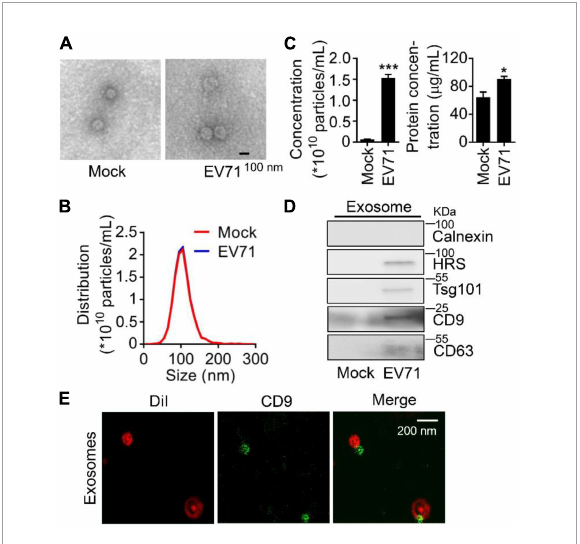
FIGURE1 Enterovirus 71 (EV71) infection promotes exosome